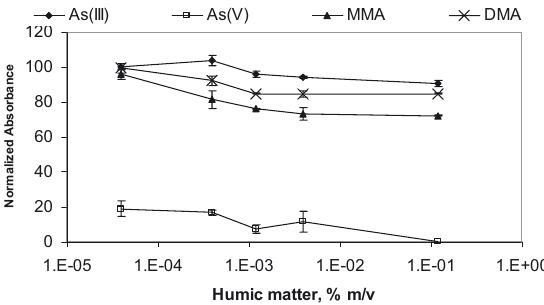
Figure 3. Effect of humic matter on generation of arsines. Absor- bance signals normalized to aqueous As(III)